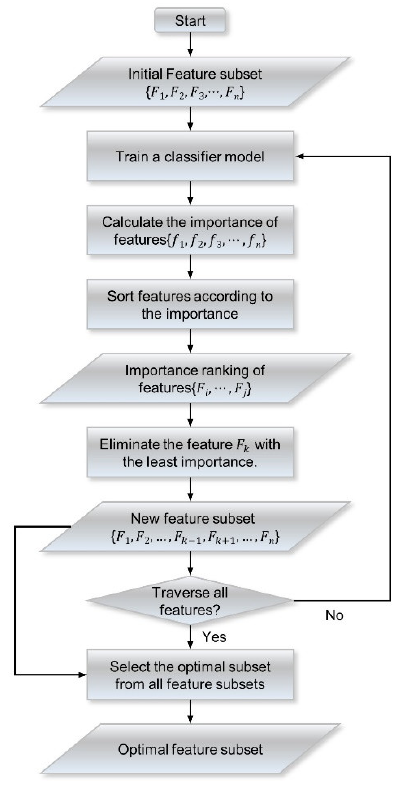
Figure 3. Flow chart of the RFE algorithm.